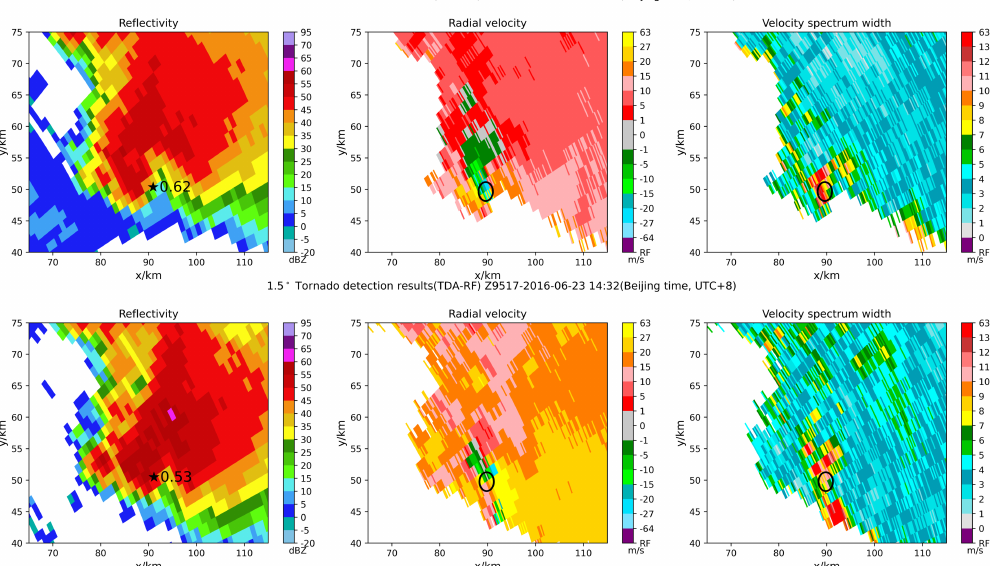
Figure 8. 0.5 ◦ and 1.5 ◦ tornado detection results (TDA-RF), Z9517-20160623-14:32 (UTC+8), the tornado was EF4. (asterisk corresponds to the identification center, and the value corresponds to the probability; the black circle has a radius of 1.5 km centered on the identification result).